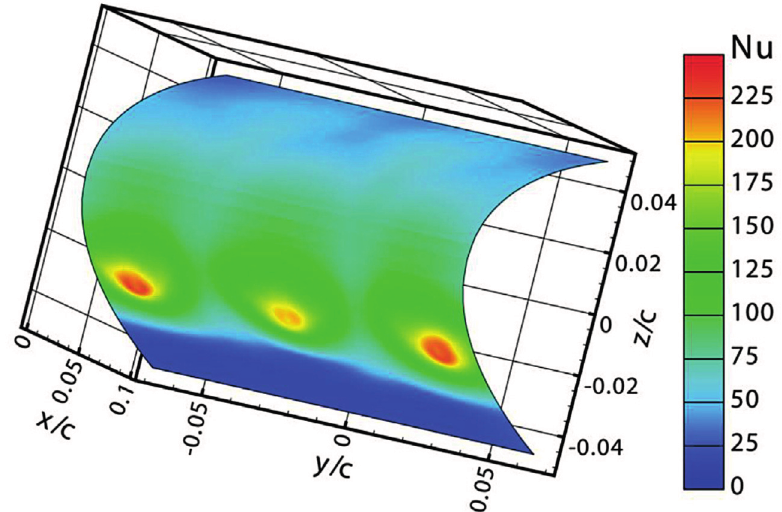
Figure 25. Nusselt number reconstruction for D = 4 mm, ϕ = 30°, M = 1.0 and p/D = 15. Adapted from Imbriale et al .